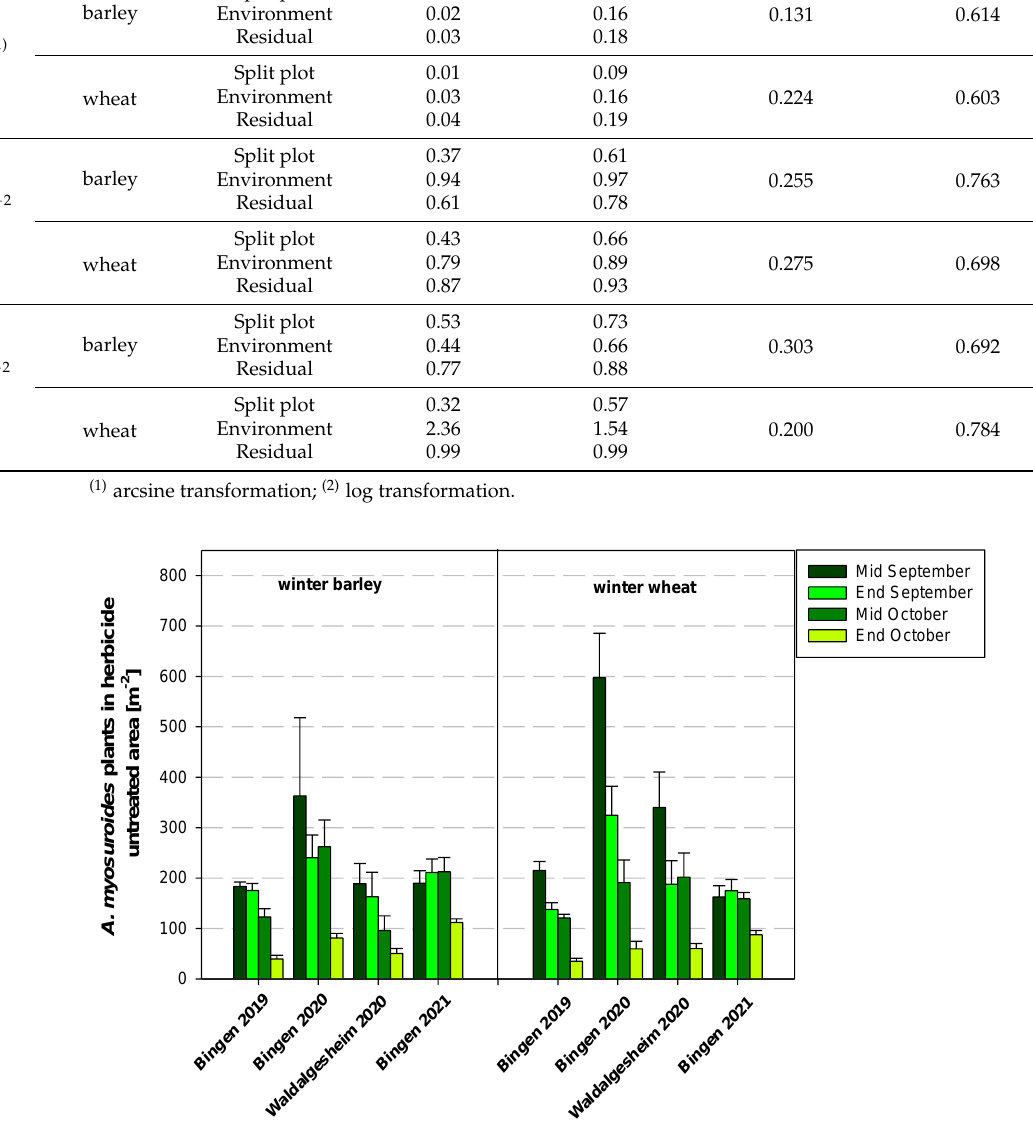
Figure 1. Density of A. myosuroides plants in herbicide-untreated areas [m −2 ] in winter barley and winter wheat depending on the sowing date (Mid-September – End-October) and the field trial (site and year), error bars represent the standard error.